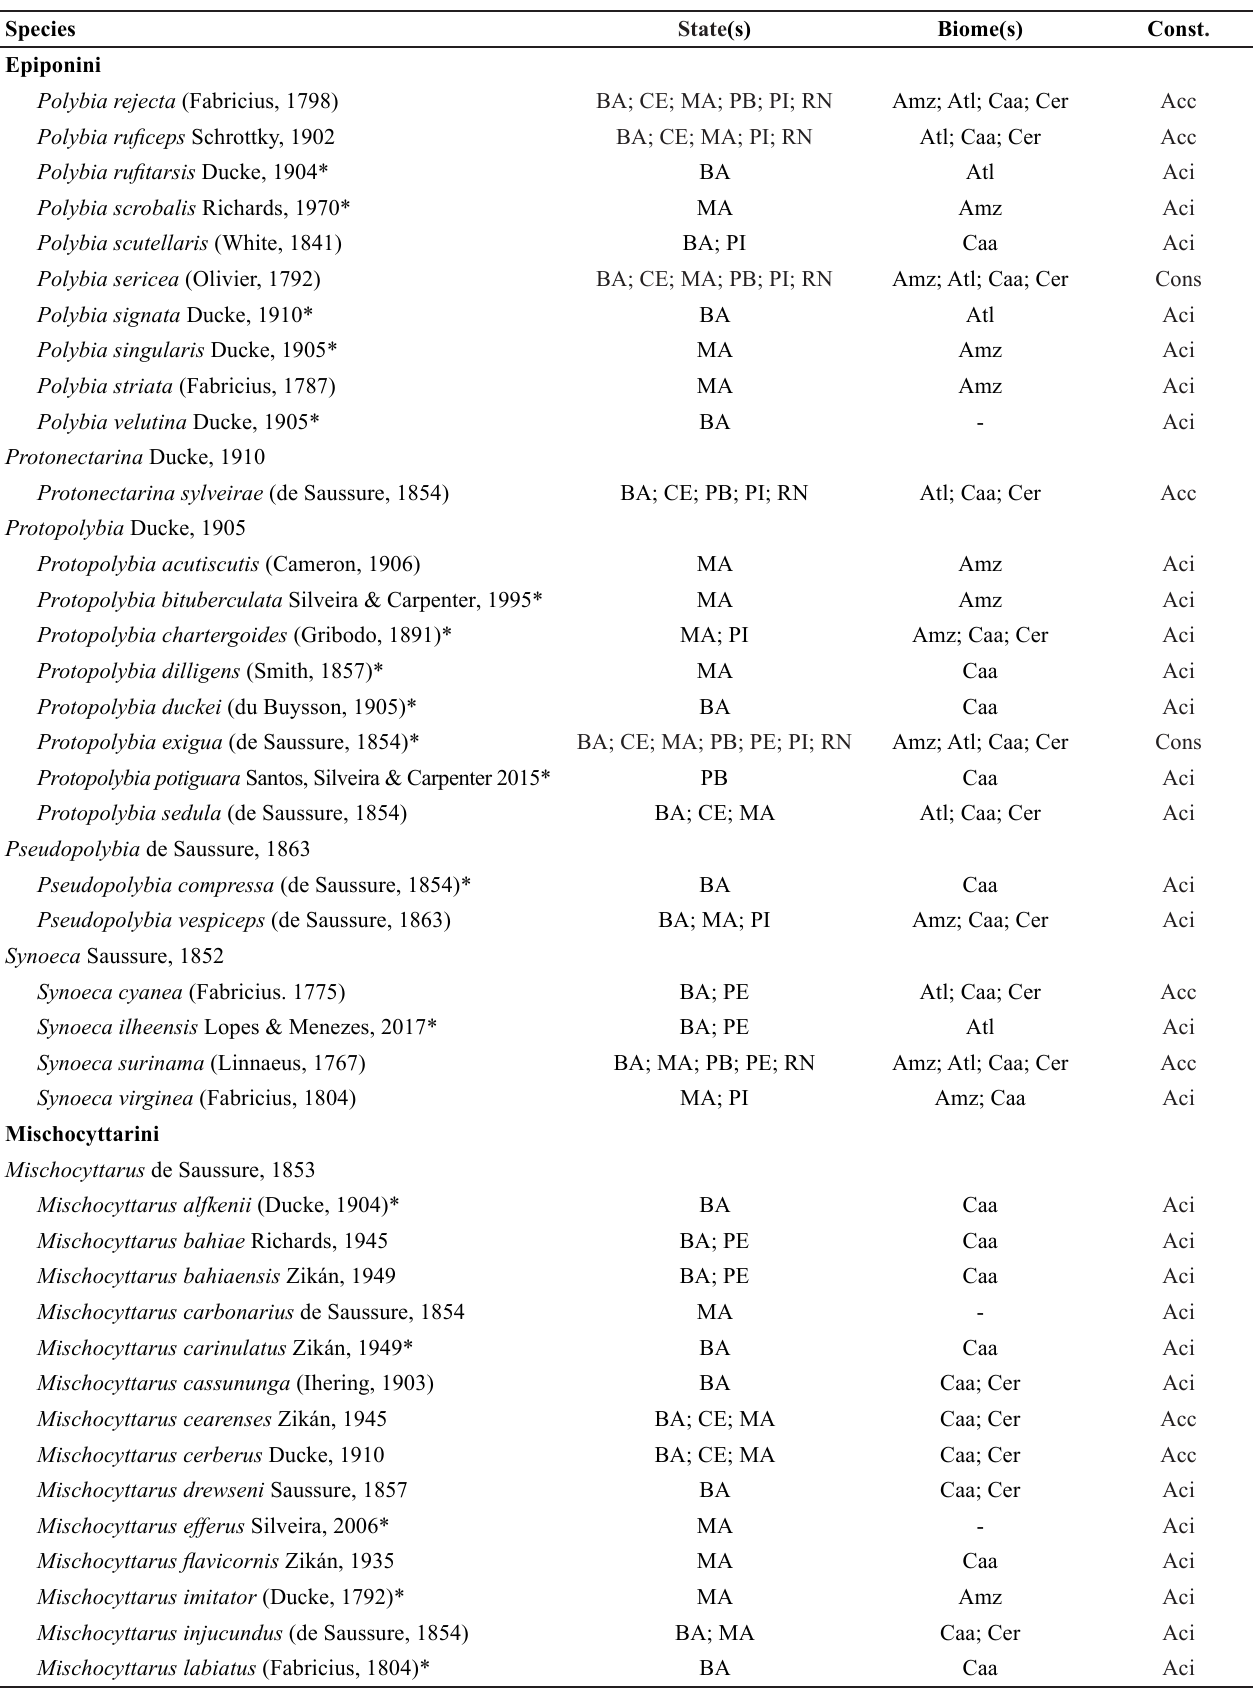
Table 2 . Species of Social Wasps registered in Northeastern Brazil. States: AL: Alagoas; BA: Bahia; CE: Ceará; MA: Maranhão, PB: Paraí- ba; PE: Pernambuco; PI: Piauí; RN: Rio Grande do Norte. Biomes: Atl: Atlantic Forest; Amz: Amazon Forest; Caa: Caatinga; Cer: Cerrado. Constance: Acc: Accessory; Aci: Accidental; Cons: Constant. *New species records after Richards (1978). (Continuation)